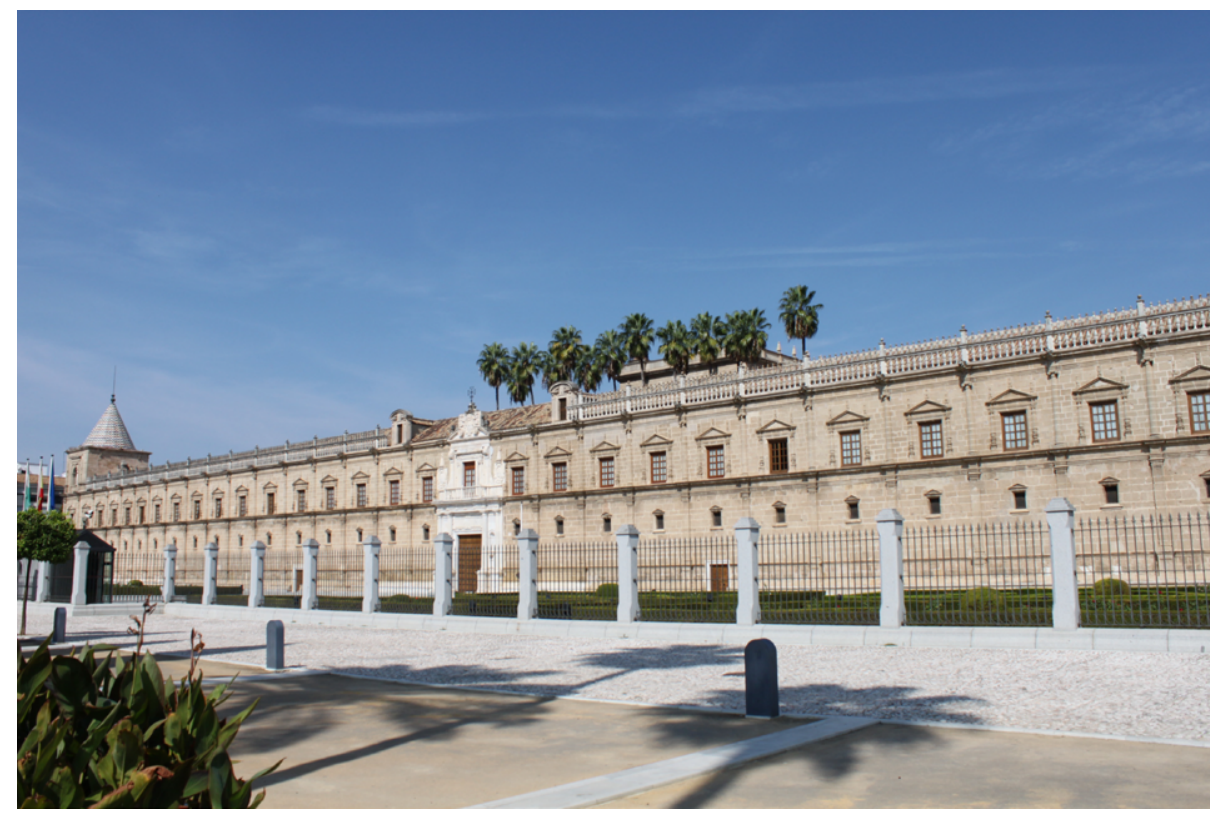
Figure 6: The principal façade of the former Hospital de las Cinco Llagas. Image from http://www.flickr.com/photos/ turismosevilla/6210413654/in/photostream/. Photo by Turismo Sevilla (Creative Commons license).